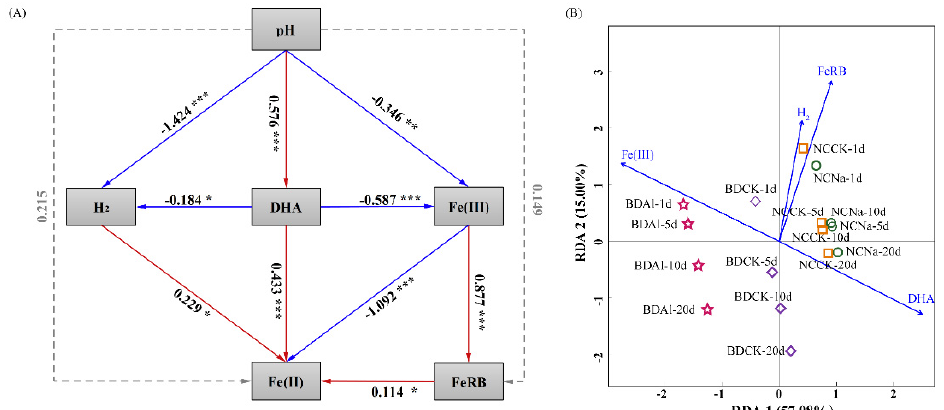
Figure 5. Structural equation modelling analysis embedding of mixed effect liner modelling ( A ) and redundancy analysis (RDA) triplot ( B ) to investigate the relationship between pH shift-mediated Fe(III) reduction and associated fermentative processes as well as succession of putative Fe(III) reducing bacteria (FeRB). (DHA, dehydrogenase activity; H 2 , partial pressure of hydrogen; Putative FeRB, the estimated abundance of putative Fe(III) reducing bacteria; Fe(II) and Fe(III), concentration of Fe(II) and Fe(III)